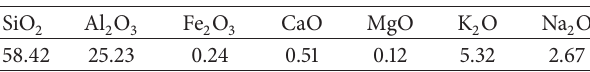
Table 2: The chemical compositions of clay.